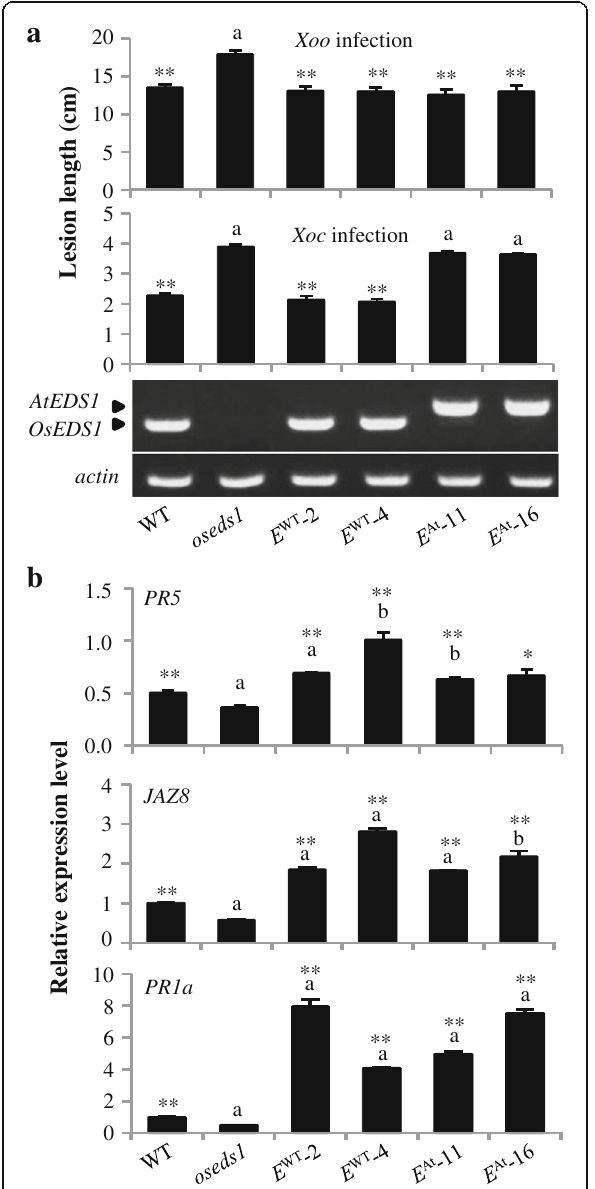
Fig. 4 Introduction of E At partially complemented oseds1 mutant phenotype. Data represent mean ± SE ( n = 10 to 56, and 3 for gene expression). Two-tail student ’ s t-test. ** and * indicate significant differences compared to oseds1 at P < 0.01 and P < 0.05, respectively. The “ a ” and “ b ” above bar indicate significant differences compared to wild-type (WT) at P < 0.01 and P < 0.05, respectively. a Introducing E At to oseds1 mutant restored plants with partially reduced susceptibility to Xoo . b Introducing E At to oseds1 mutant restored PR5 , JAZ8 , and PR1a expression